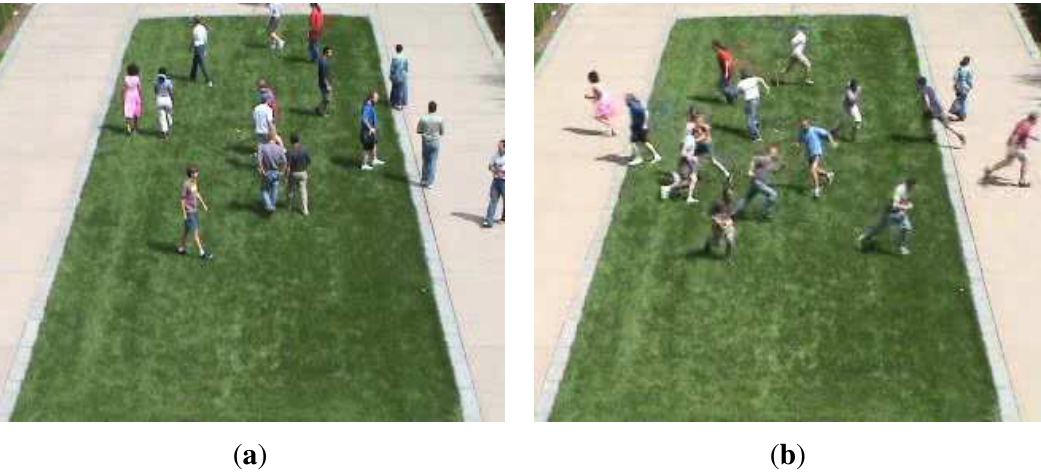
Figure 1. Examples of the normal and abnormal scenes. ( a ) A normal lawn scene: all the people are walking; ( b ) An abnormal lawn scene: all the people are